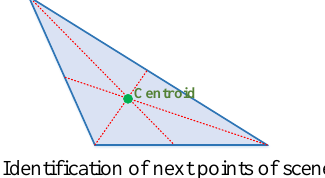
Figure 2: Identification of next points of scene to be reconstructed